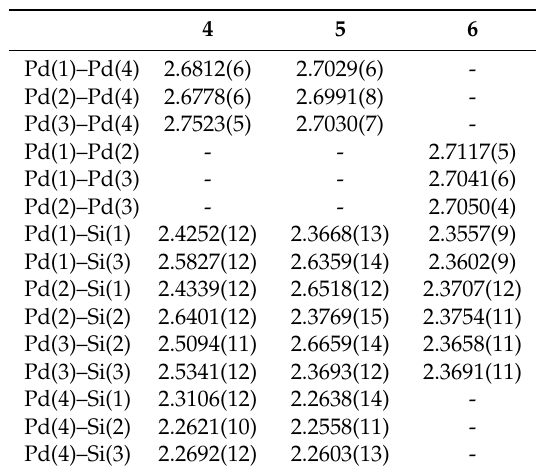
Figure 3. ( a ) Top view of the molecular structure of 6 with 50% probability ellipsoids. Hydrogen atoms were omitted for clarity; ( b ) Side view of 6 . All atoms derived from the phosphite ligands except for the coordinated phosphorus atoms, and all hydrogen atoms were omitted for clarity. Table 1. Selected bond distances for 4 , 5 and 6 .